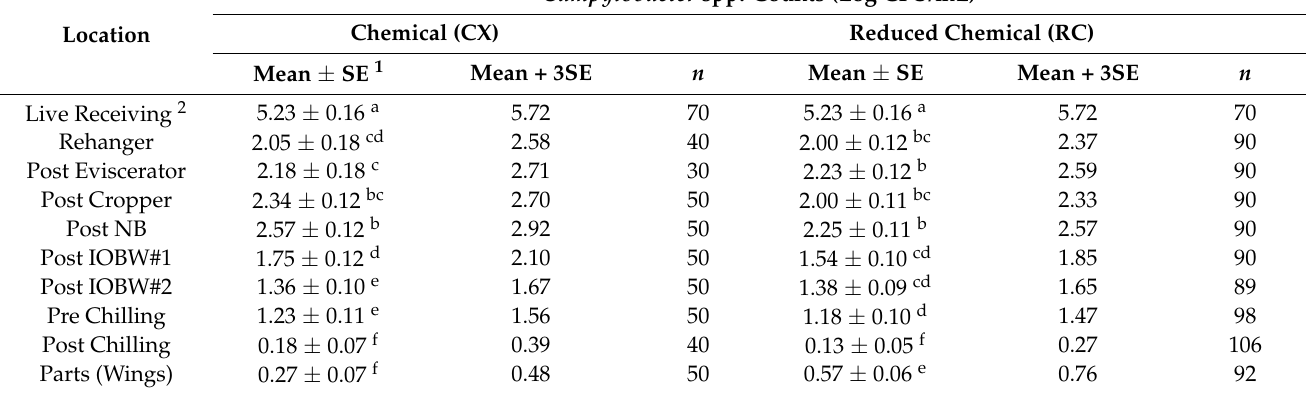
Table 6. Campylobacter spp. counts (log CFU/mL) on each of the ten locations during the evisceration process under normal process interventions (CX) and low-chemical process interventions (RC) on chicken rinses.